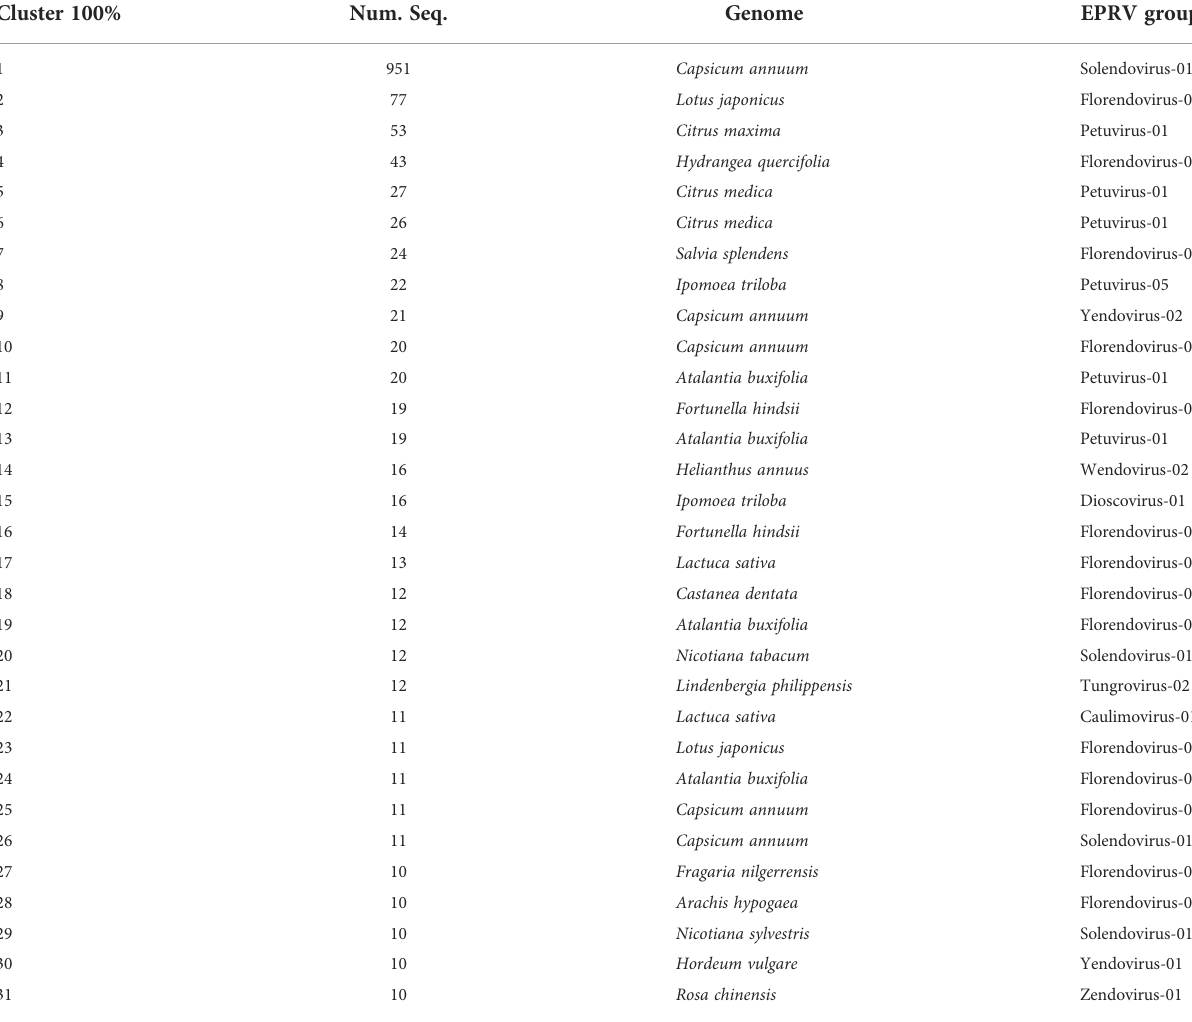
TABLE 3 Cluster 100 with 10 or more